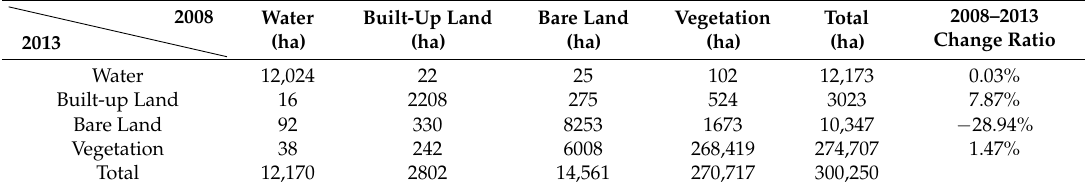
Table 5. Land-cover transfer matrix from 2008 to 2013.